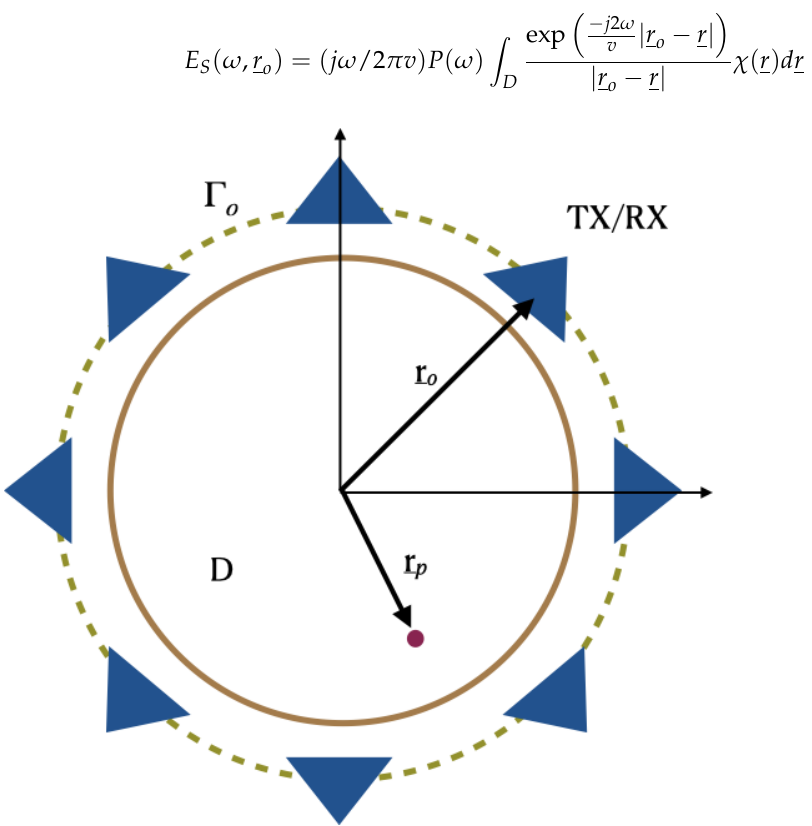
Figure 1. Pictorial view of the scattering scene. Invariance is assumed along the z